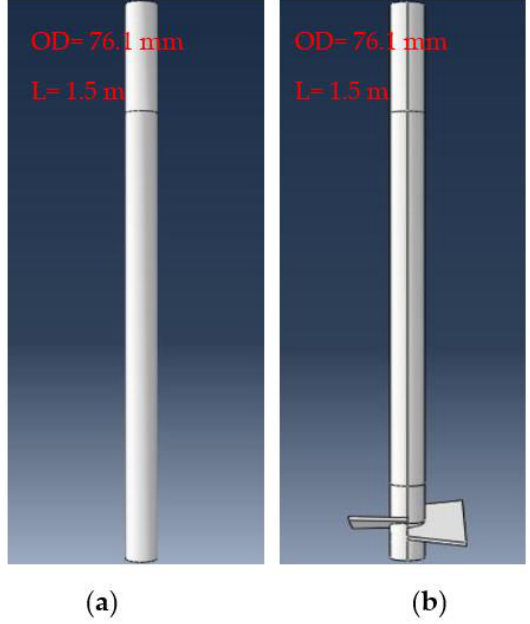
Figure 1. ( a ) Abaqus for CHSB 0 P; ( b ) Abaqus for CHSB 1 P.